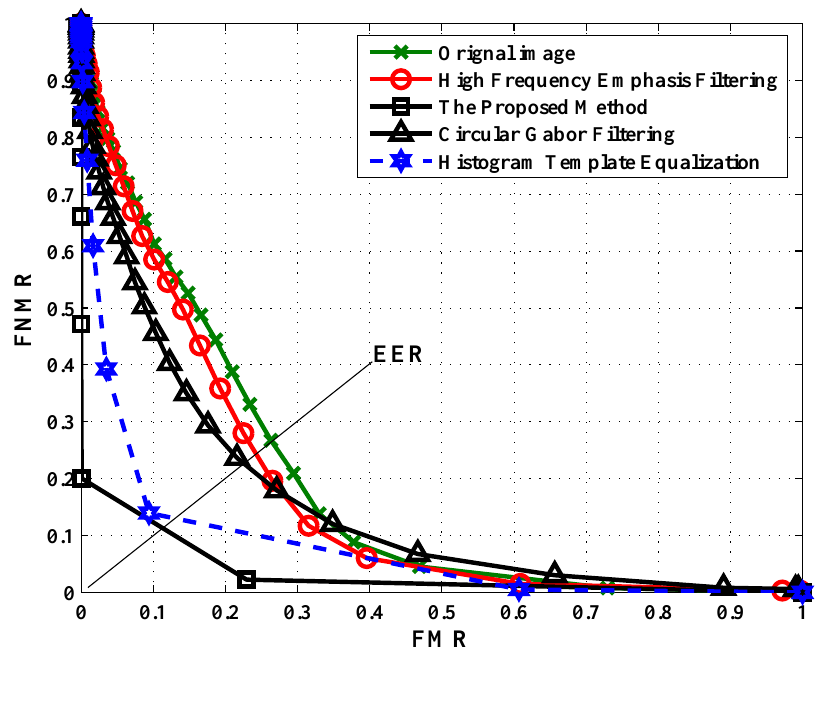
Figure 11. ROC curves of different finger-vein enhancement